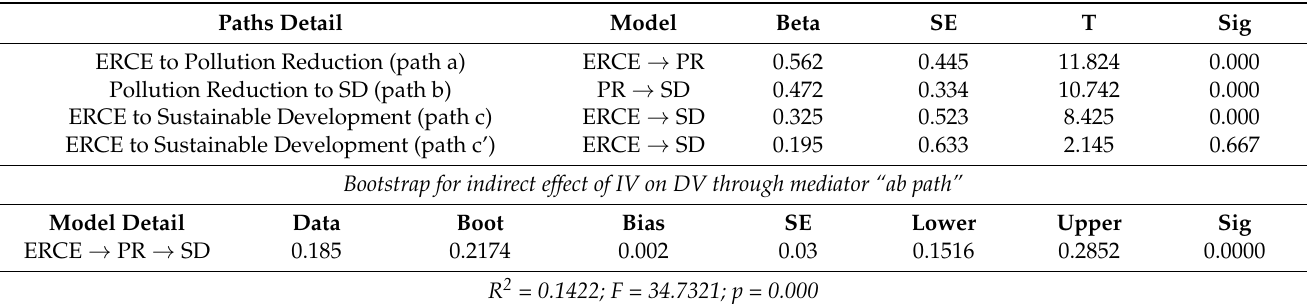
Table 5. Mediation effects showing different paths a, b, c, and